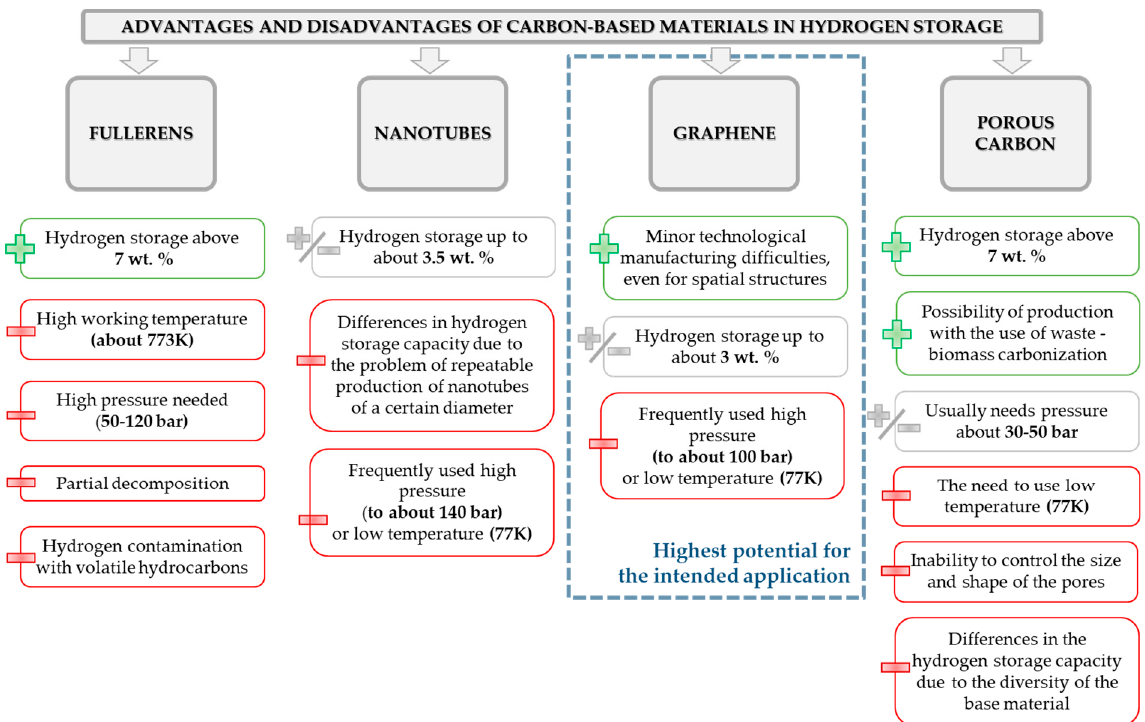
Figure 13. Summary of the advantages and disadvantages of frequently used carbon-based materials intended to use for hydrogen storage.